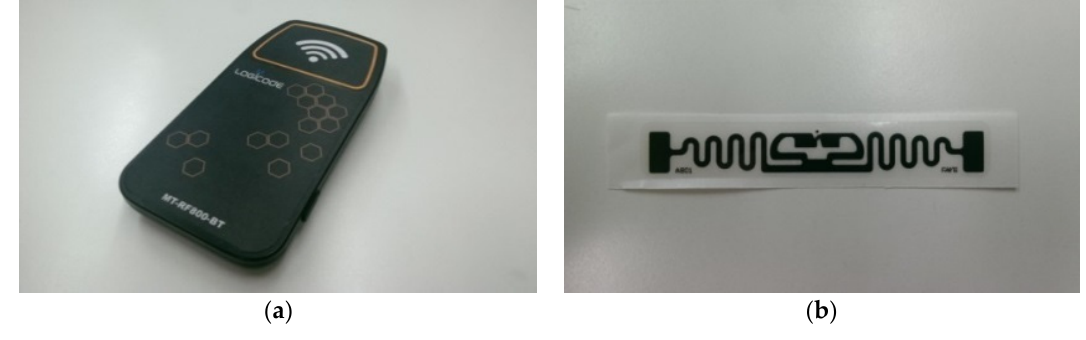
Figure 16. ( a ) Ultra High Frequency (UHF) RFID reader MT ‐ RF800 ‐ BT and ( b ) UHF tag.